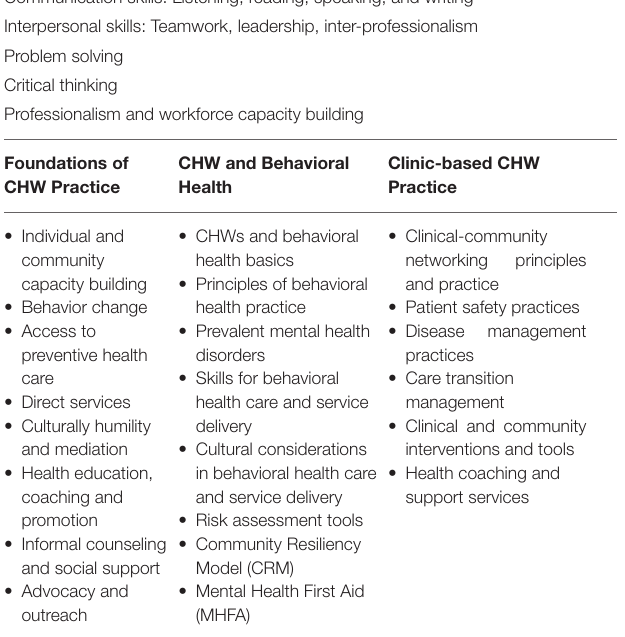
TABLE 1 | The academy’s core competencies and main training topics. Community Health Workers/Promotores Academy Core Competencies: Communication skills: Listening, reading, speaking, and writing Interpersonal skills: Teamwork, leadership, inter-professionalism